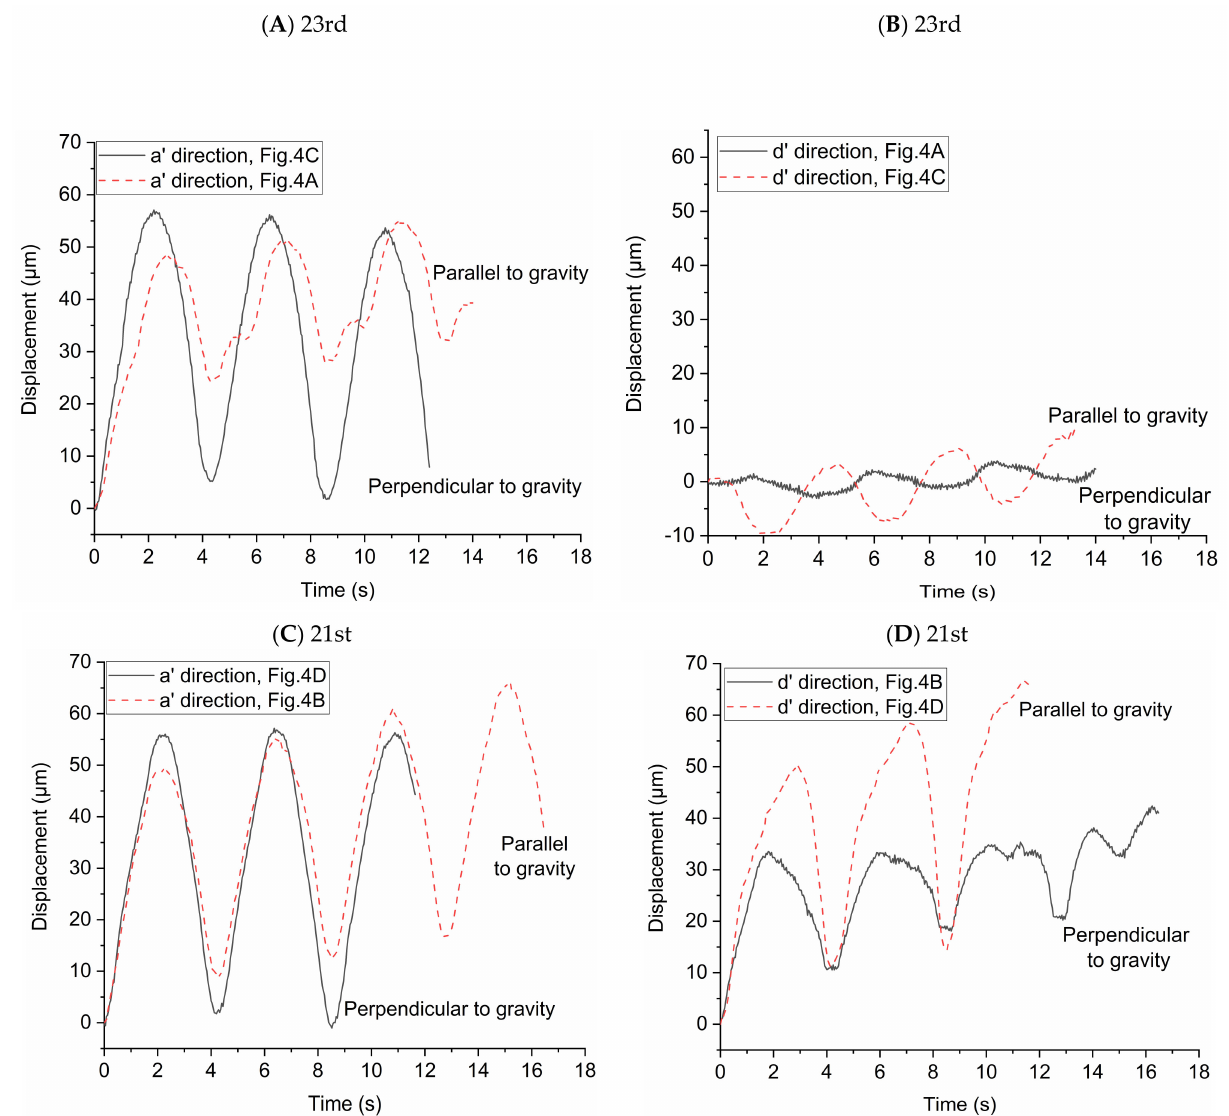
Figure 5. Statistical average displacement of particles in two directions under zero and normal gravity. ( A ) Displacement of particles in the a’ direction at the 23rd generation. ( B ) Displacement of particles in the d’ direction at the 23rd generation. ( C ) Displacement of particles in the a’ direction at the 21st generation. ( D ) Displacement of particles in the d’ direction at the 21st